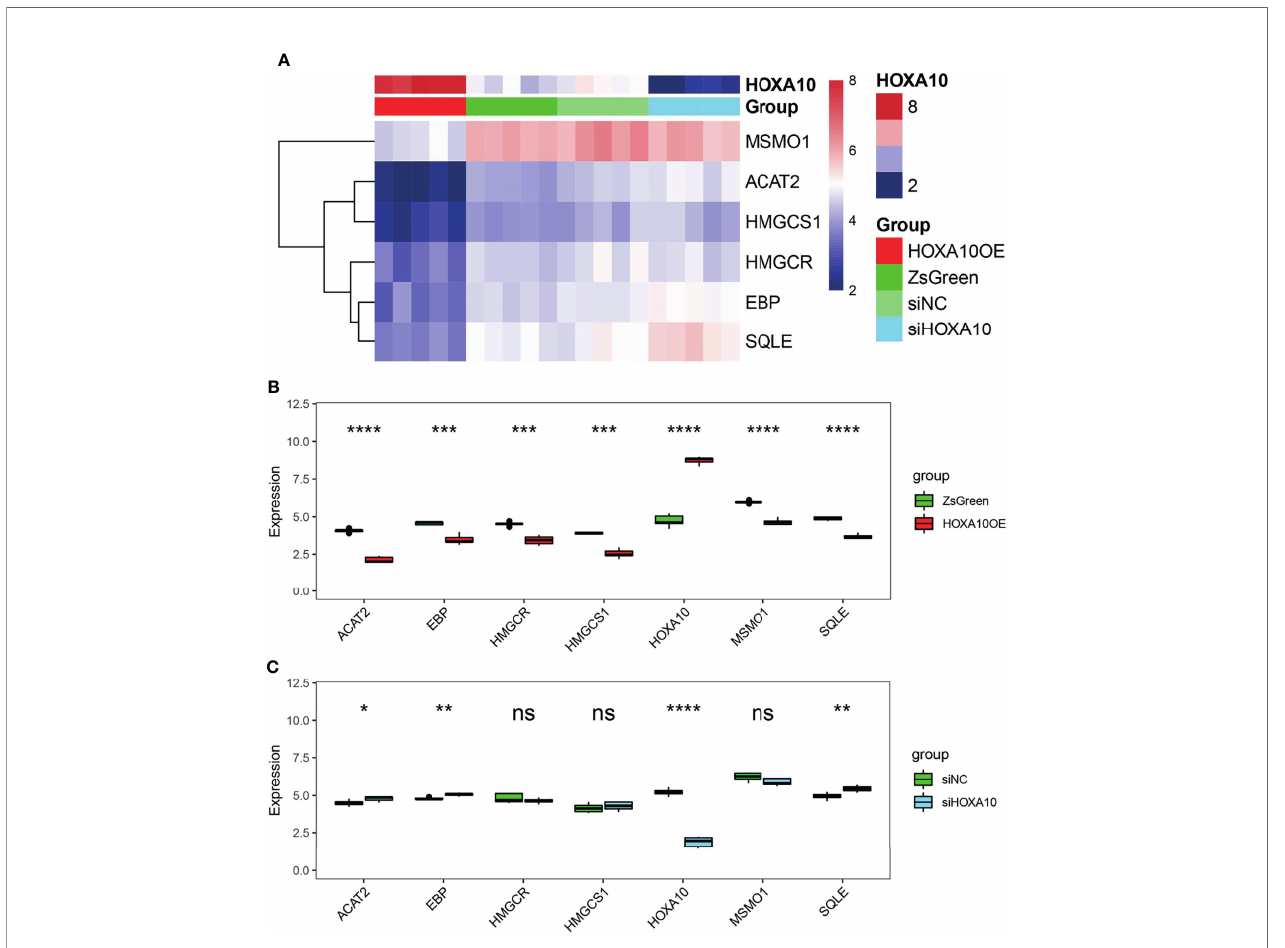
FIGURE 5 | The regulatory effect of HOXA10 on key genes. (A) Heatmap of key genes in HOXA10OE, ZsGreen, siHOXA10, and siNC groups. (B) The comparison of key genes mRNA expression in HOXA10OE and ZsGreen groups. (C) The comparison of key genes mRNA expression in siHOXA10 and siNC groups (HOXA10OE, HOXA10 over expression ESC; ZsGreen, control for over-expression group; siHOXA10, HOXA10 silence ESC; siNC, control for silence group. *p<0.05, **p<0.01, ***p<0.001, ****p<0.0001; ns, no signi fi cant difference).